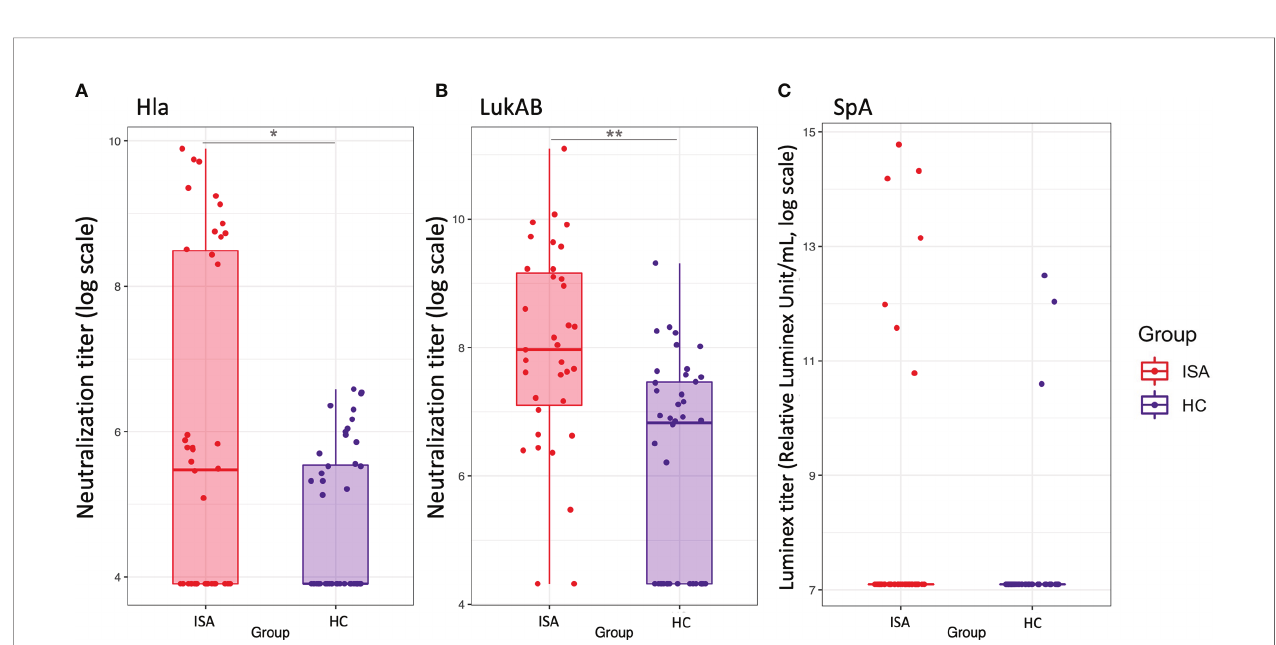
FIGURE 5 | Functional antibodies against Hla, LukAB and Spa. Boxplot and scatterplot are reported to summarize functional antibodies quanti fi cation levels. (A, B) , report the values of neutralization titers for Hla and LukAB toxins, respectively, de fi ned as the reciprocal serum dilution which neutralizes the toxicity by 50%. (C) reports the values of functional titers for SpA binding to FcgRI, as calculated by a Luminex-based measurement. Samples in ISA group and HC are indicated in red and blue, respectively. Stars on top or bottom of the boxes report the level of signi fi cance of the Welch ’ s t-test p-values on the means: *< 0.05, **<